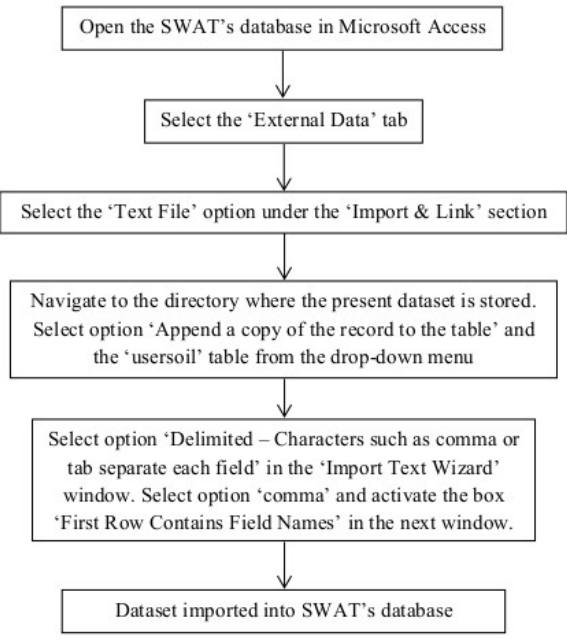
Figure 4. Flowchart showing the steps for importing the present soils dataset into SWAT’s